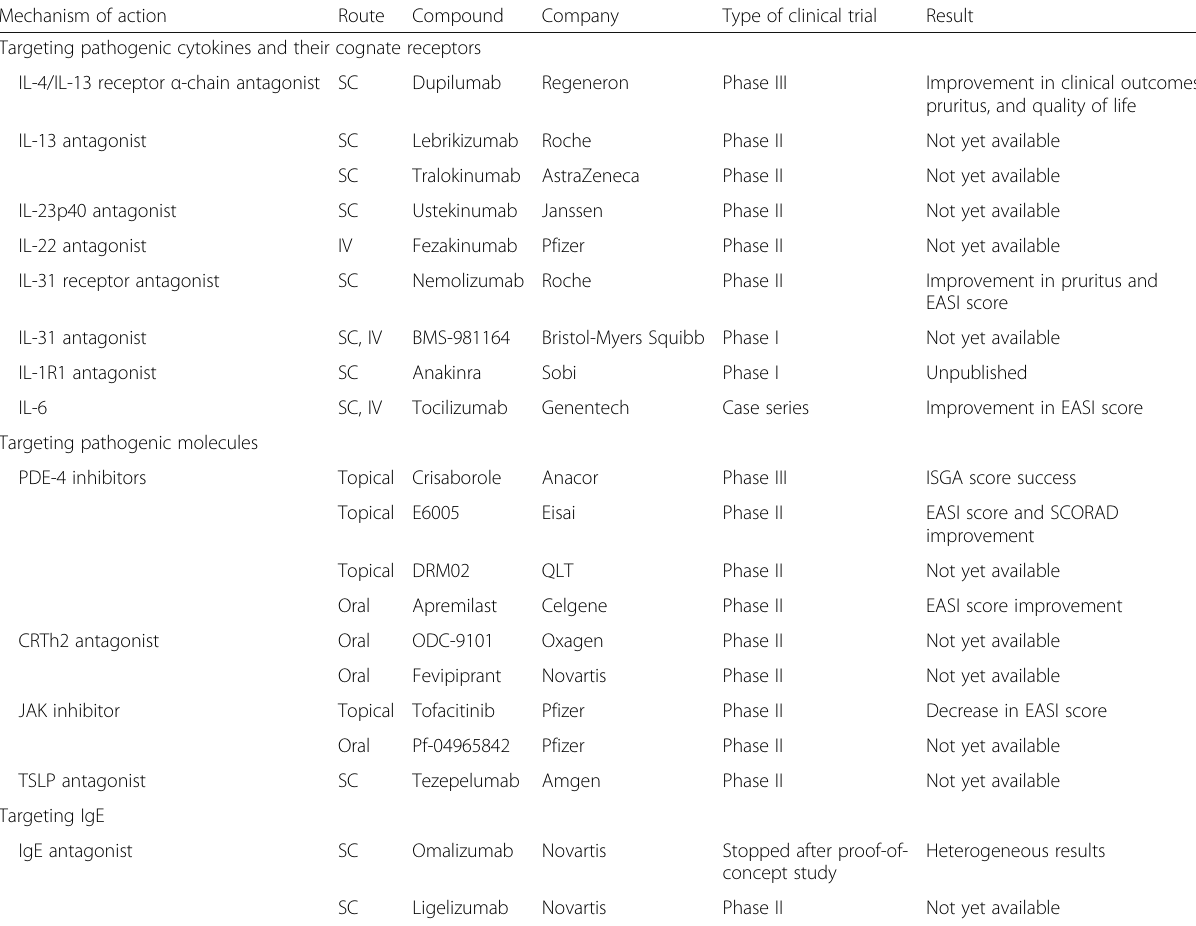
Table 1 Novel AD treatments. The table is modified from Heratizadeh and Werfel [178], Lauffer and Ring [179], Noda et al. [180], Nomura and Kabashima [173], and Werfel et al.